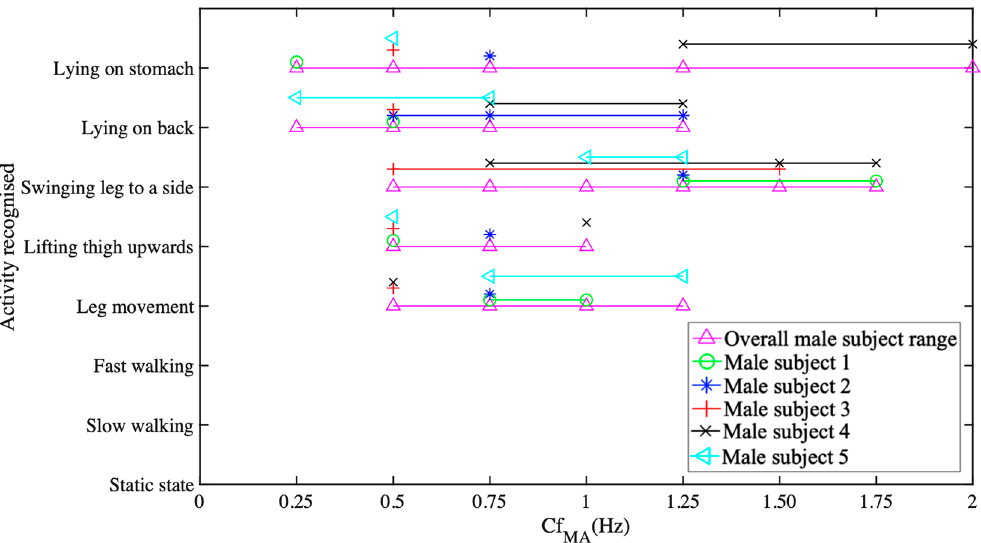
Figure 4. Personalized activity recognition comparison of five male subjects vs. overall subject range with respect to Cf MA.